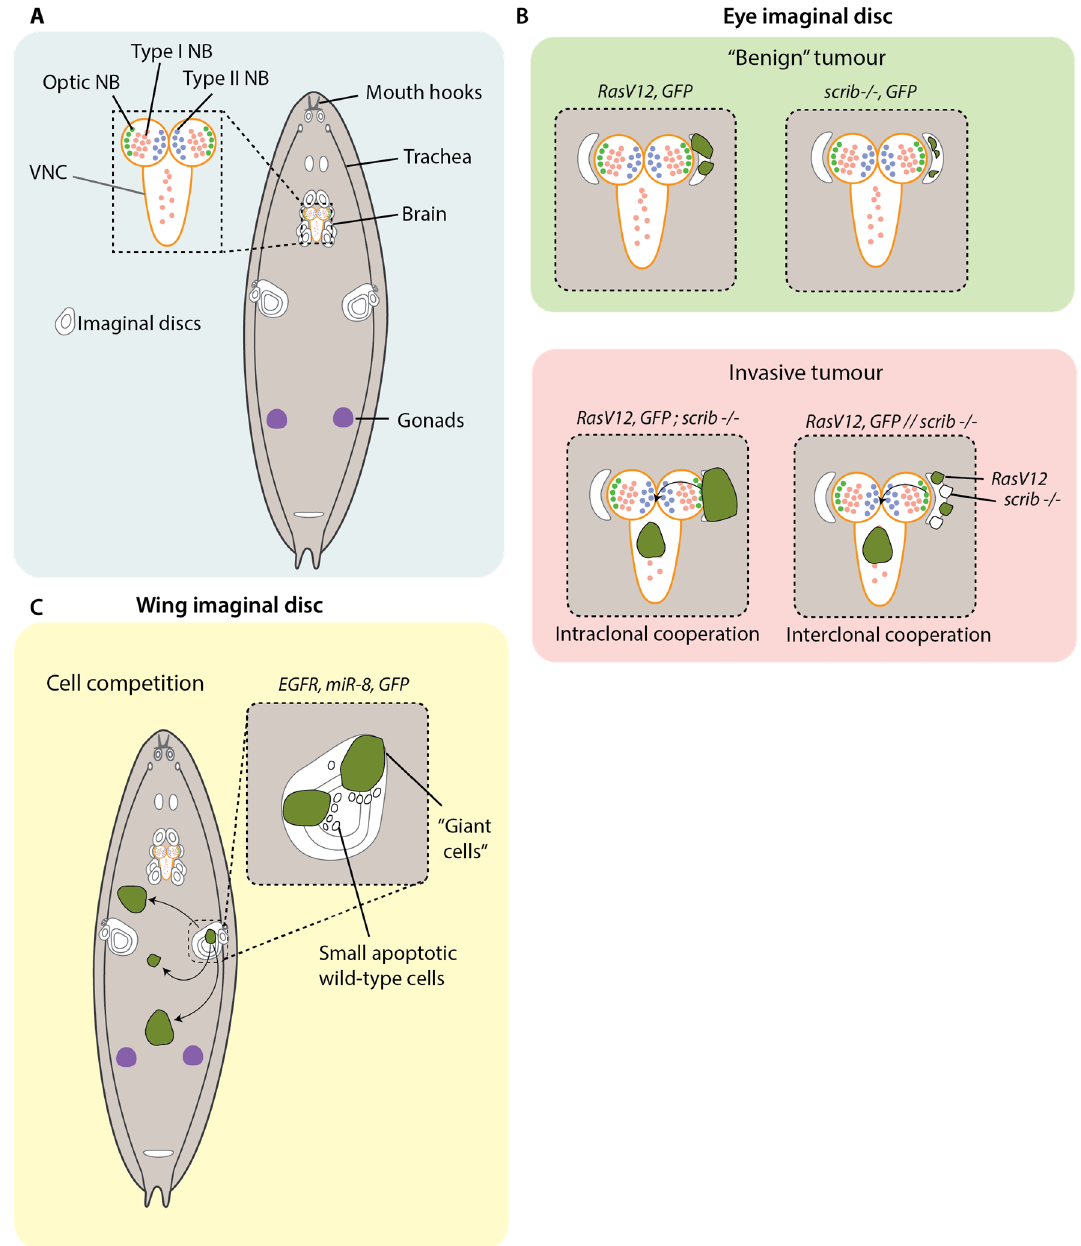
Figure 2. Modelling metastasis in Drosophila larvae. ( A ) Drosophila larva, showing tissues that undergo mitosis: neuroblasts, imaginal disc cells and gonads. NB = neuroblast; VNC = ventral nerve cord. ( B ) Ras V12 and scrib − / − tumours in the eye imaginal disc form non-invasive tumours. Intraclonal (both mutations within the same clone) and interclonal (mutations in adjacent clones) cooperation between of loss of a tumour suppressor gene such as scrib and expression of an oncogene such as Ras V12 results in invasion of the VNC that is reminiscent of the initial stages of metastasis [32,33]. Intraclonal cooperation has also been observed between Ras V12 and mutant mitochondrial respiration complexes [34]. ( C ) Tumours over expressing EGFR and mIR-8 in the wing imaginal disc grow into neoplasms that can disseminate throughout the larva. A subset of these cells develops into “giant cells” flanked by differentiated wild-type cells. The smaller wild-type cells are engulfed by the giant cells in an apoptosis-dependent manner [35].